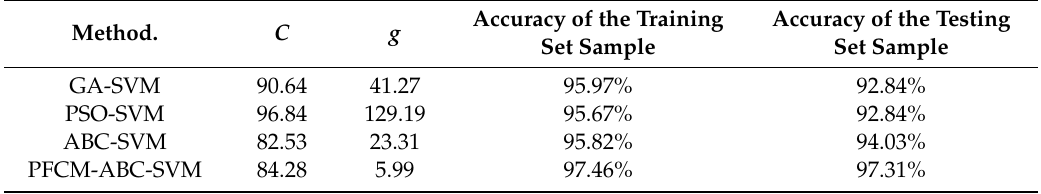
Table 3. The comparison between the PFCM-ABC-SVM method and the other methods.